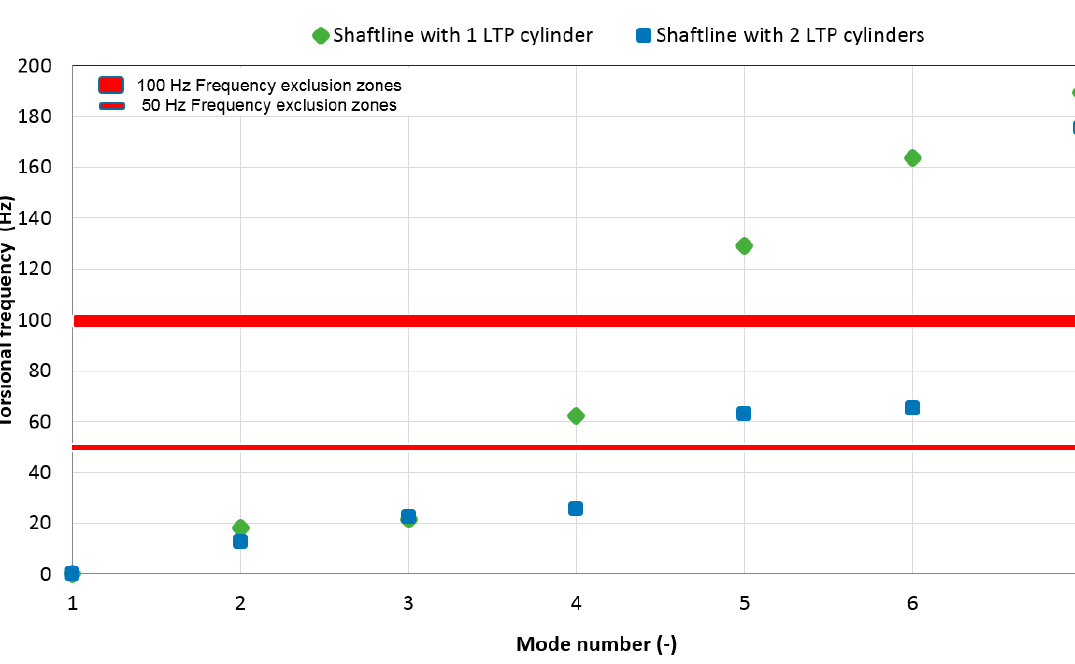
Figure 13. Evaluating monoblock LPT cylinder shaft frequency.